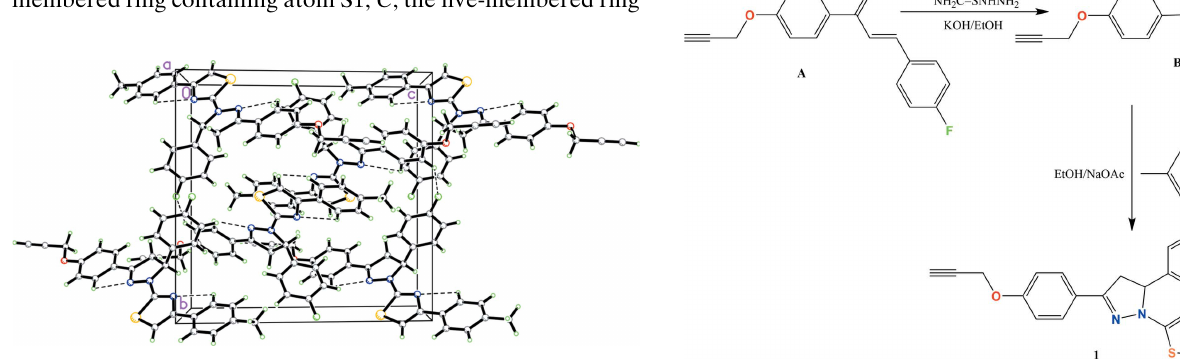
Figure 2 Packing diagram showing intermolecular C—H (cid:4)(cid:4)(cid:4) S and C—H (cid:4)(cid:4)(cid:4) F interactions, as well as intramolecular C—H (cid:4)(cid:4)(cid:4) N interactions, as dashed lines.